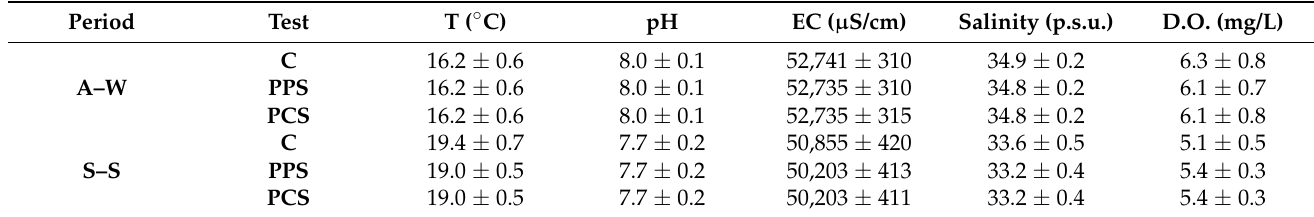
Table 1. Physicochemical parameters of seawater measured during the